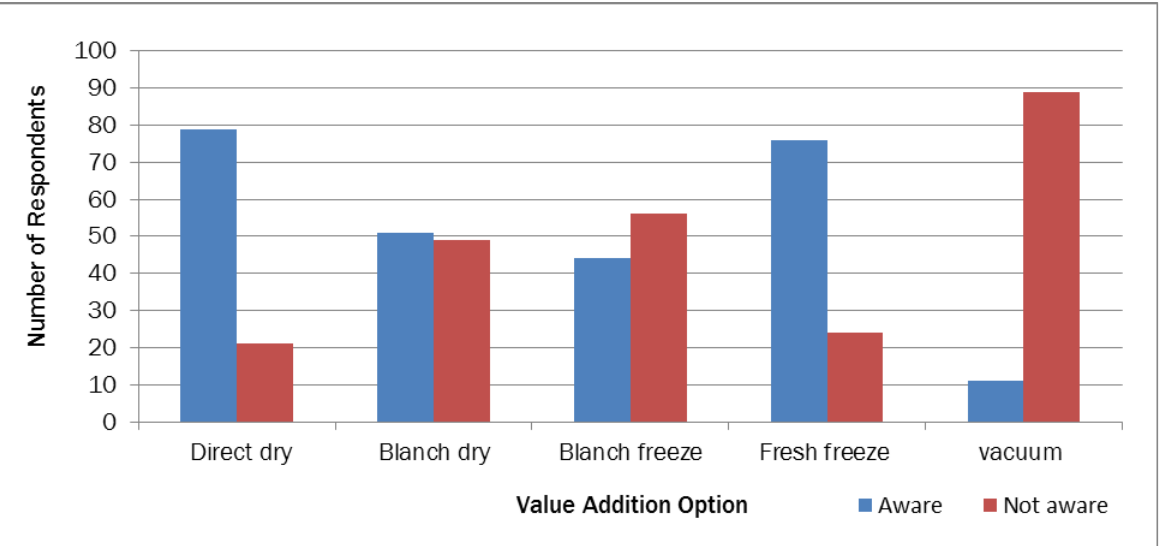
Figure 3. Have You Ever Heard of the Following Value-Addition Activities? (%, N